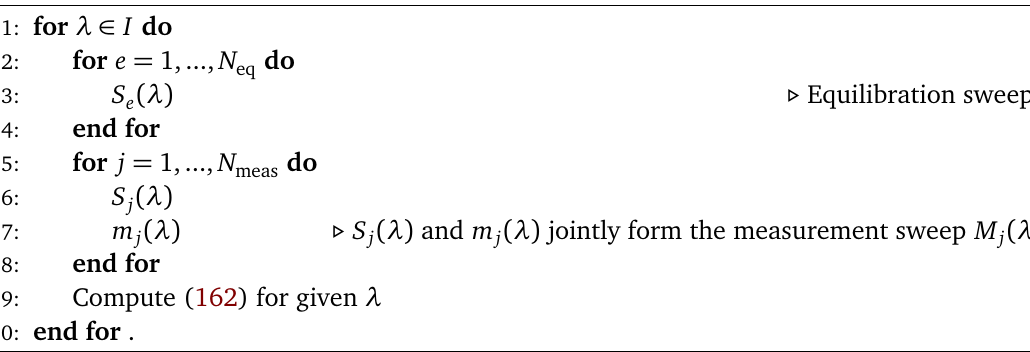
Algorithm 1 Population dynamics sampling